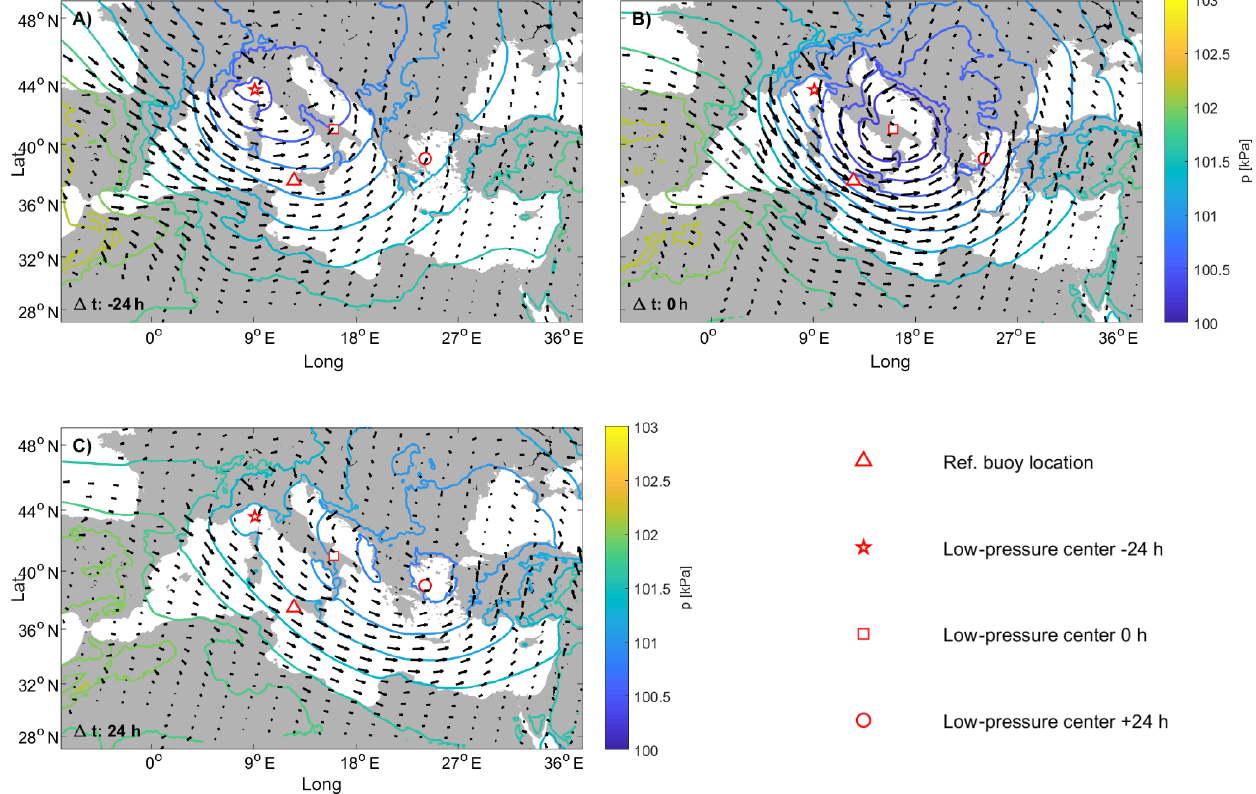
Figure 9. WP#2: average MSLP evolution with respect to the reference dates of the events in B4 (underlined with the red triangle).